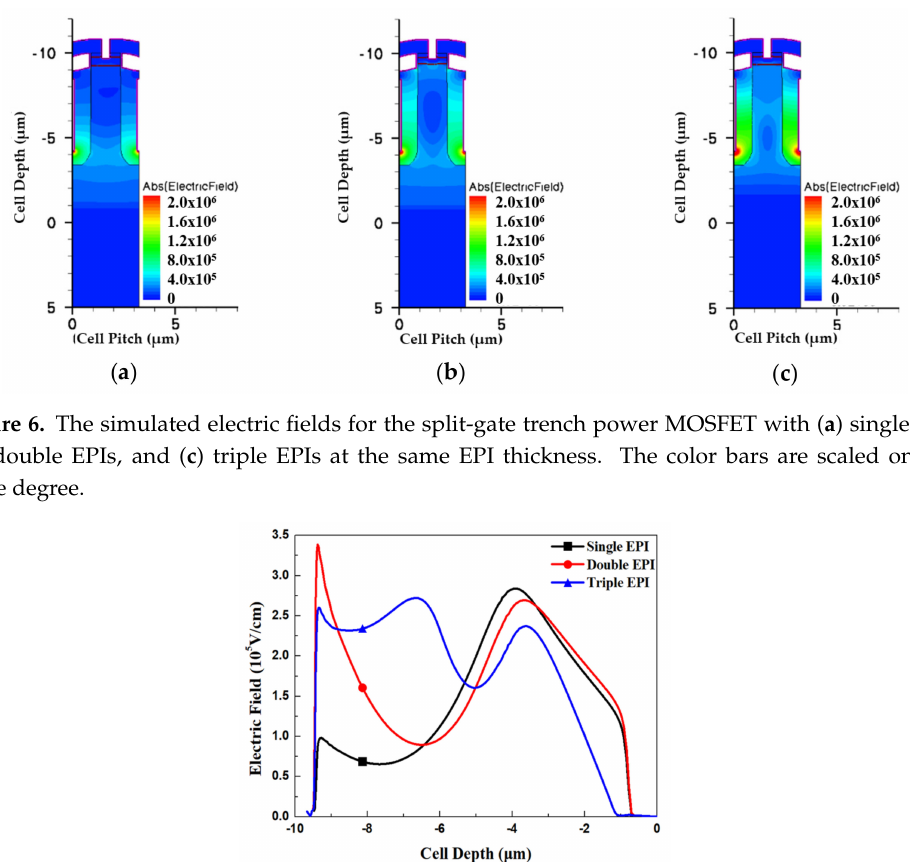
Figure 5. The simulated potentials for the split-gate trench power MOSFET with ( a ) single EPI, ( b ) double EPIs, and ( c ) triple EPIs at the same EPI thickness. The color bars are scaled on the same degree.